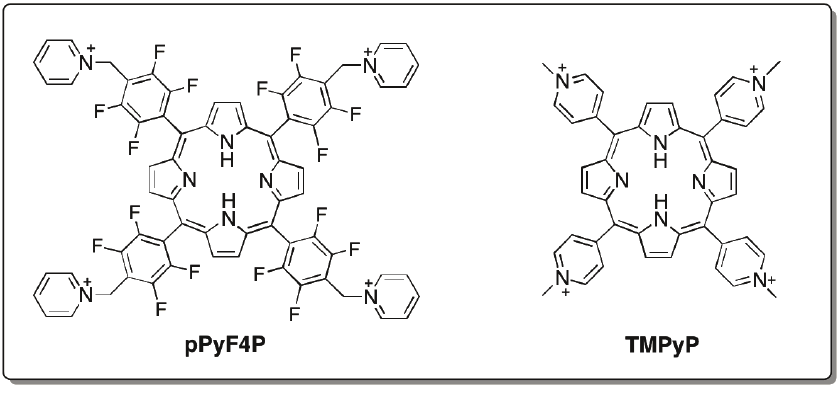
Figure 6. Chemical structures of two cationic porphyrins (pPyF4P and